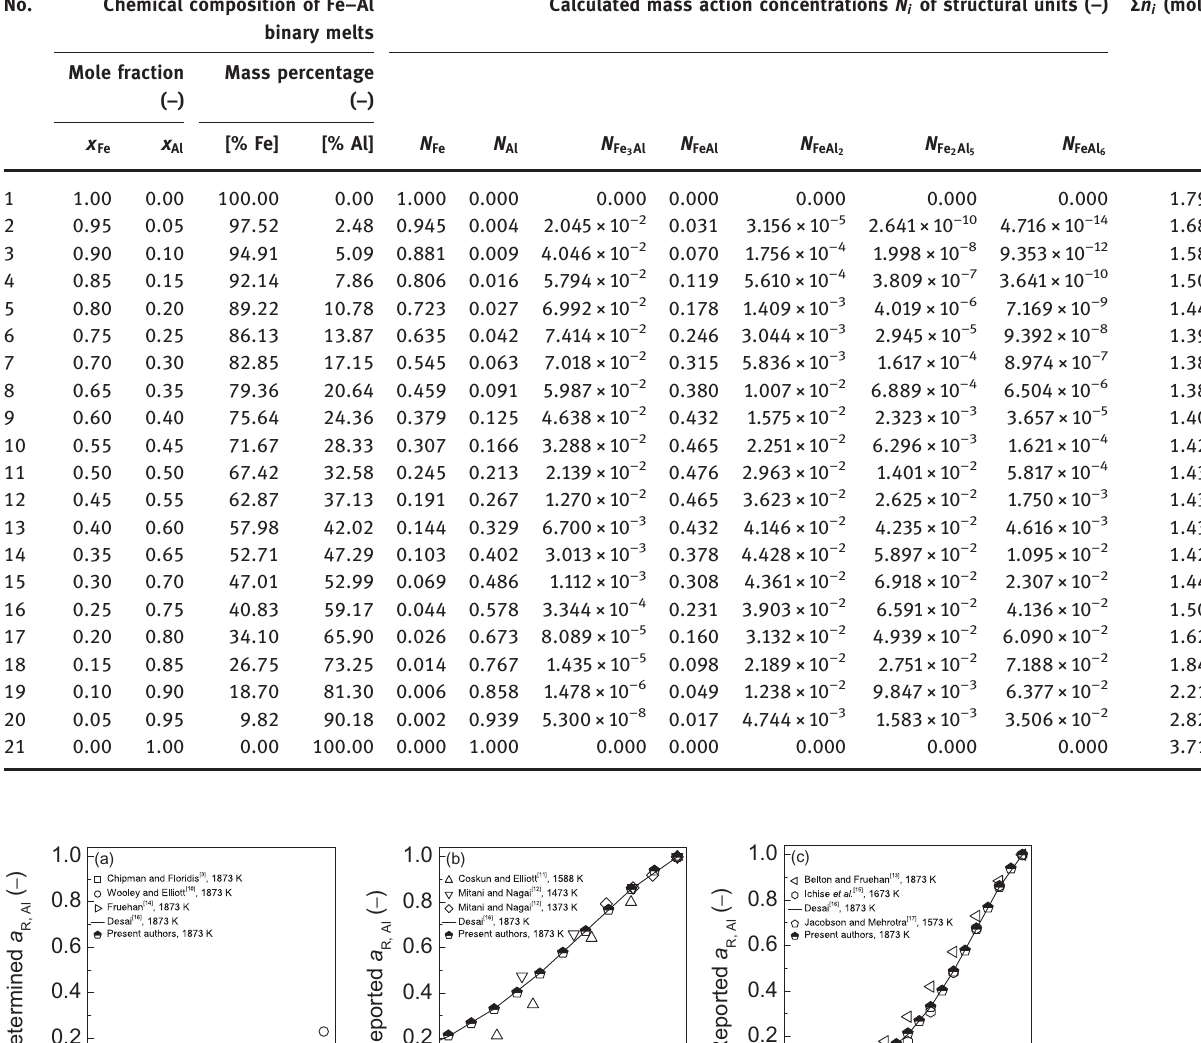
Table 6: Chemical composition of Fe – Al binary melts with changing mole fraction x Al of Al from 0.0 to 1.0, calculated mass action concentrations N i of seven structural units as Fe, Al, Fe 3 Al, FeAl, FeAl 2 , Fe 2 Al 5 , and FeAl 6 , and total equilibrium mole number Σ n i of seven